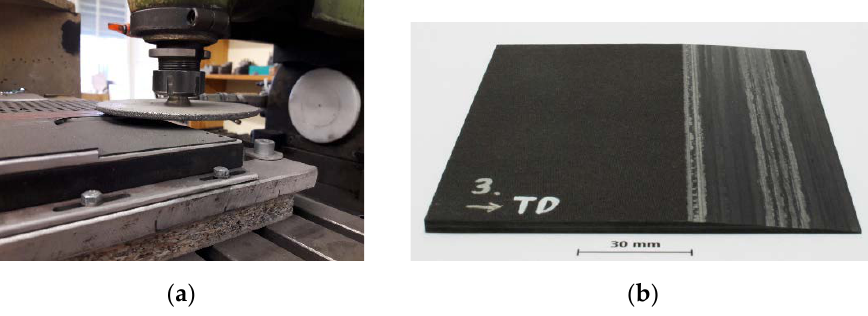
Figure 2. ( a ) Milling device; ( b ) overview of scarfed sample after